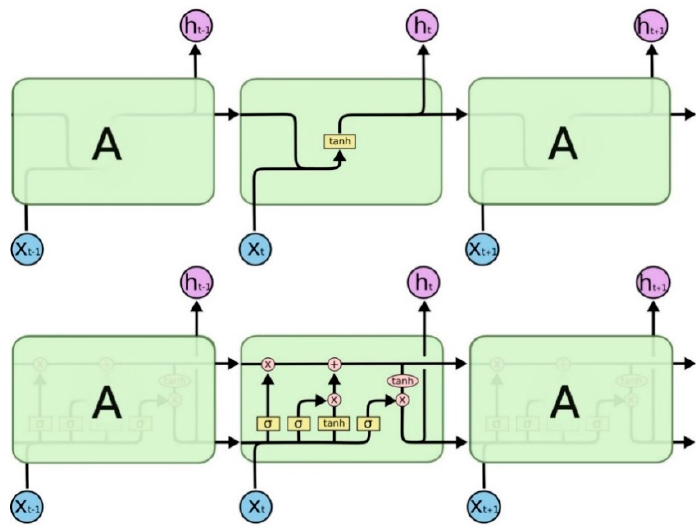
Figure 4. Unrolled RNN (Recurrent Neural Networks) cell structure (top) vs. LSTM (Long-Short Term Memory) cell structure (bottom) (http://colah.github.io/posts/2015-08-Understanding-LSTMs/).